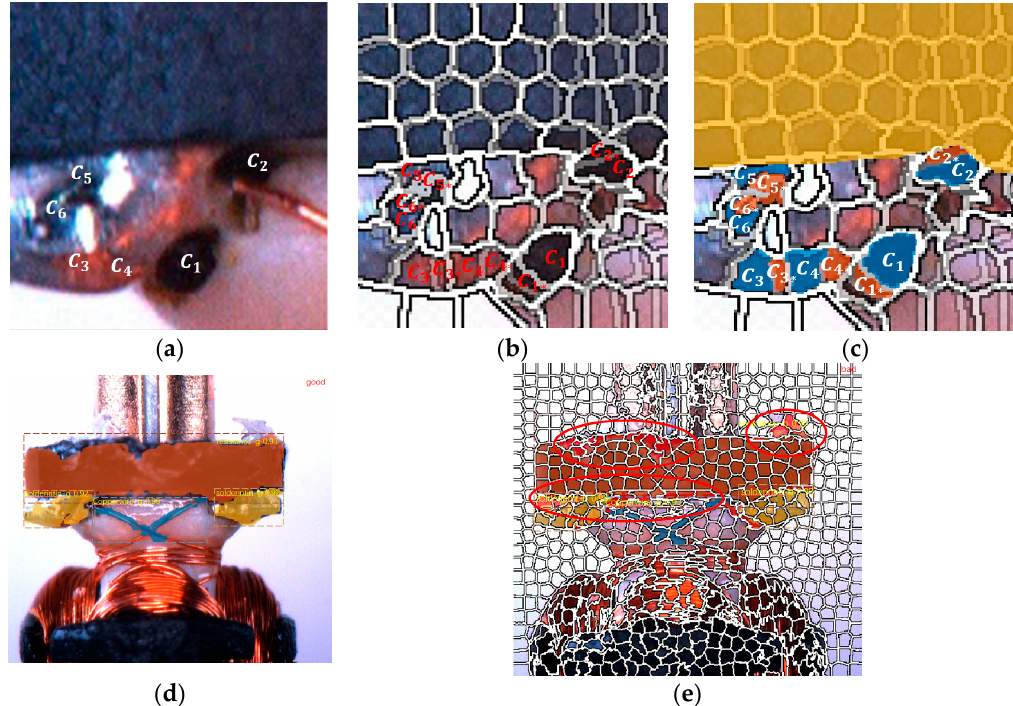
Figure 4. 𝐶 (cid:2869) , 𝐶 (cid:2870) ,𝐶 (cid:2871) … 𝐶 (cid:2874) are the clutter detection area (( a ), ( b ), ( c )). The trained model to detect and Figure 4. C 1 , C 2 , C 3 ... C 6 are the clutter detection area ( a – c ). The trained model to detect and segment segment three objects show in the ( d ) and ( e ), which as shown in the red circle, the red labeled pixels three objects show in the ( d , e ), which as shown in the red circle, the red labeled pixels are reincorporated are reincorporated into the labeled simple linear iterative clustering (SLIC) cells to achieve into the labeled simple linear iterative clustering (SLIC) cells to achieve augmentation of the mask. augmentation of the mask, ).( a ) S ho ws the o riginal image with defects, ( b ) describe s the deviation ( a ) Shows the original image with defects, ( b ) describesthe deviation caused by superpixel segmentation, caused by superpixel segmentation, ( c ) shows the process of au gmentation, ( d ) illustrate s the ( c ) shows the process of augmentation, ( d ) illustrates the segmentation method based on mask, ( e ) shows segmentation method based on mask, ( e ) shows the result of our method.. the result of our